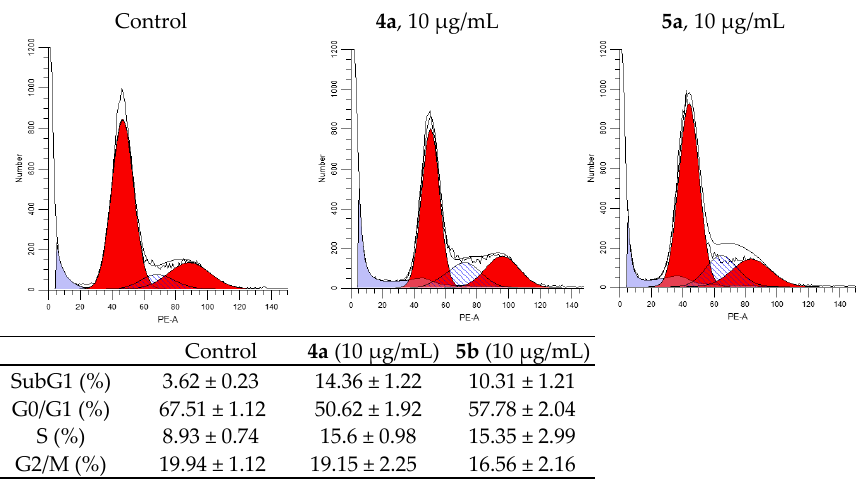
Figure 4. Effect of spiro-fused tryptanthrines and pyrrolo[3,4- a ]pyrrolizines 4a and 5a on the distri- bution of K562 cells in the cell cycle.